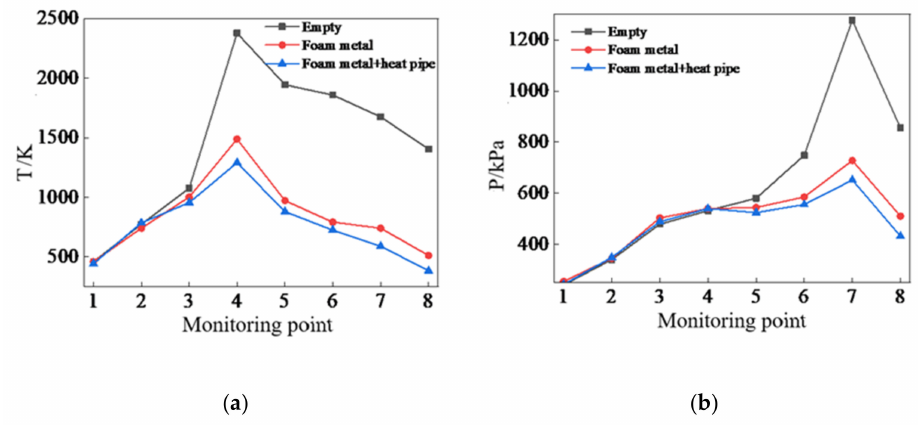
Figure 26. Maximum temperature and overpressure at each monitoring point. ( a ) Maximum temper- ature at each monitoring point; ( b ) maximum overpressure at each monitoring